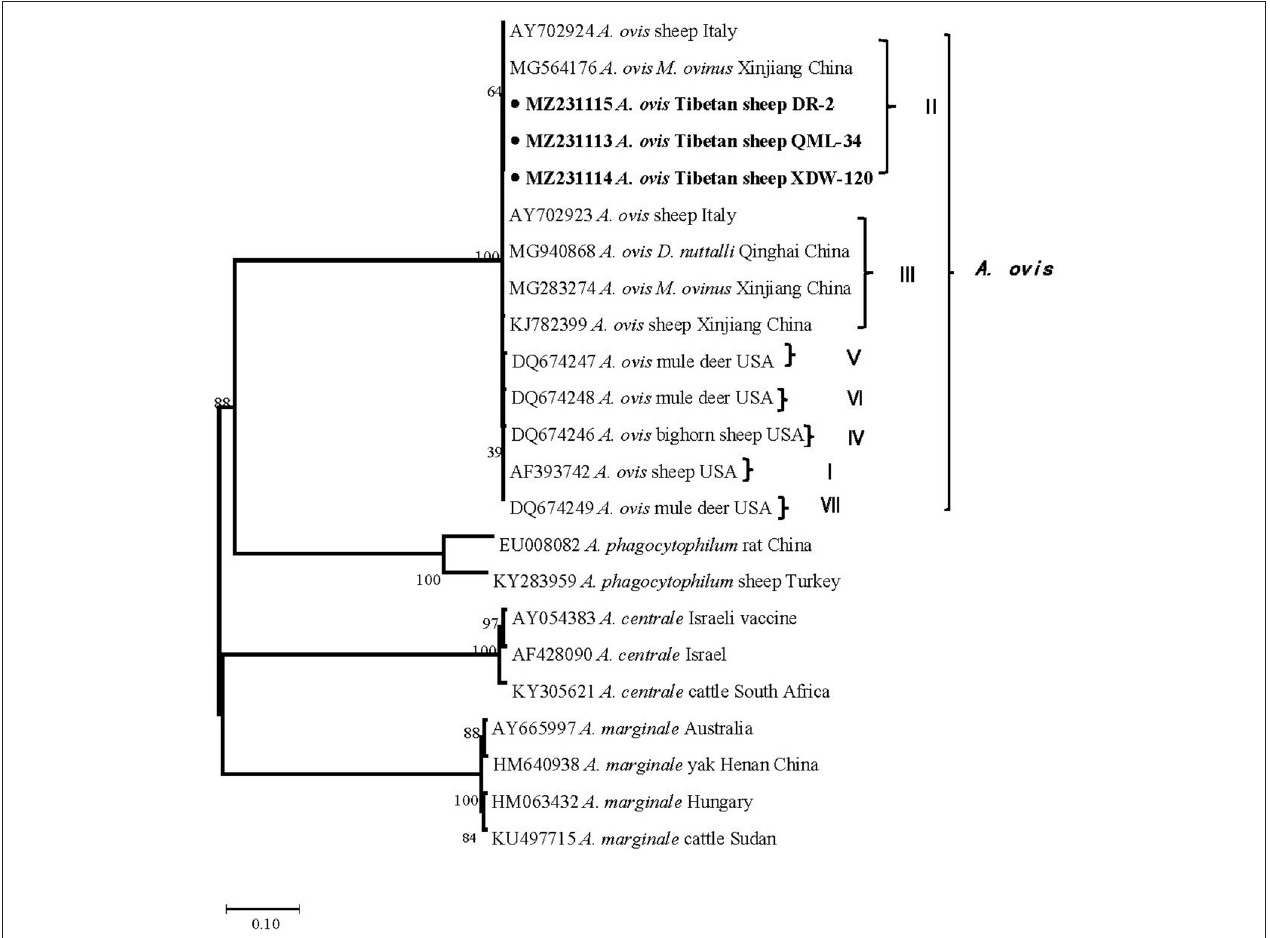
FIGURE 4 | Phylogenetic trees were constructed based on the msp4 genes of A. ovis . Phylogenetic trees were constructed by the neighbor-joining method with the p-distance model using the MEGA X software, and the bootstrap test was assessed with 1,000 replicates. The species identified in this study are indicated by • and highlighted in